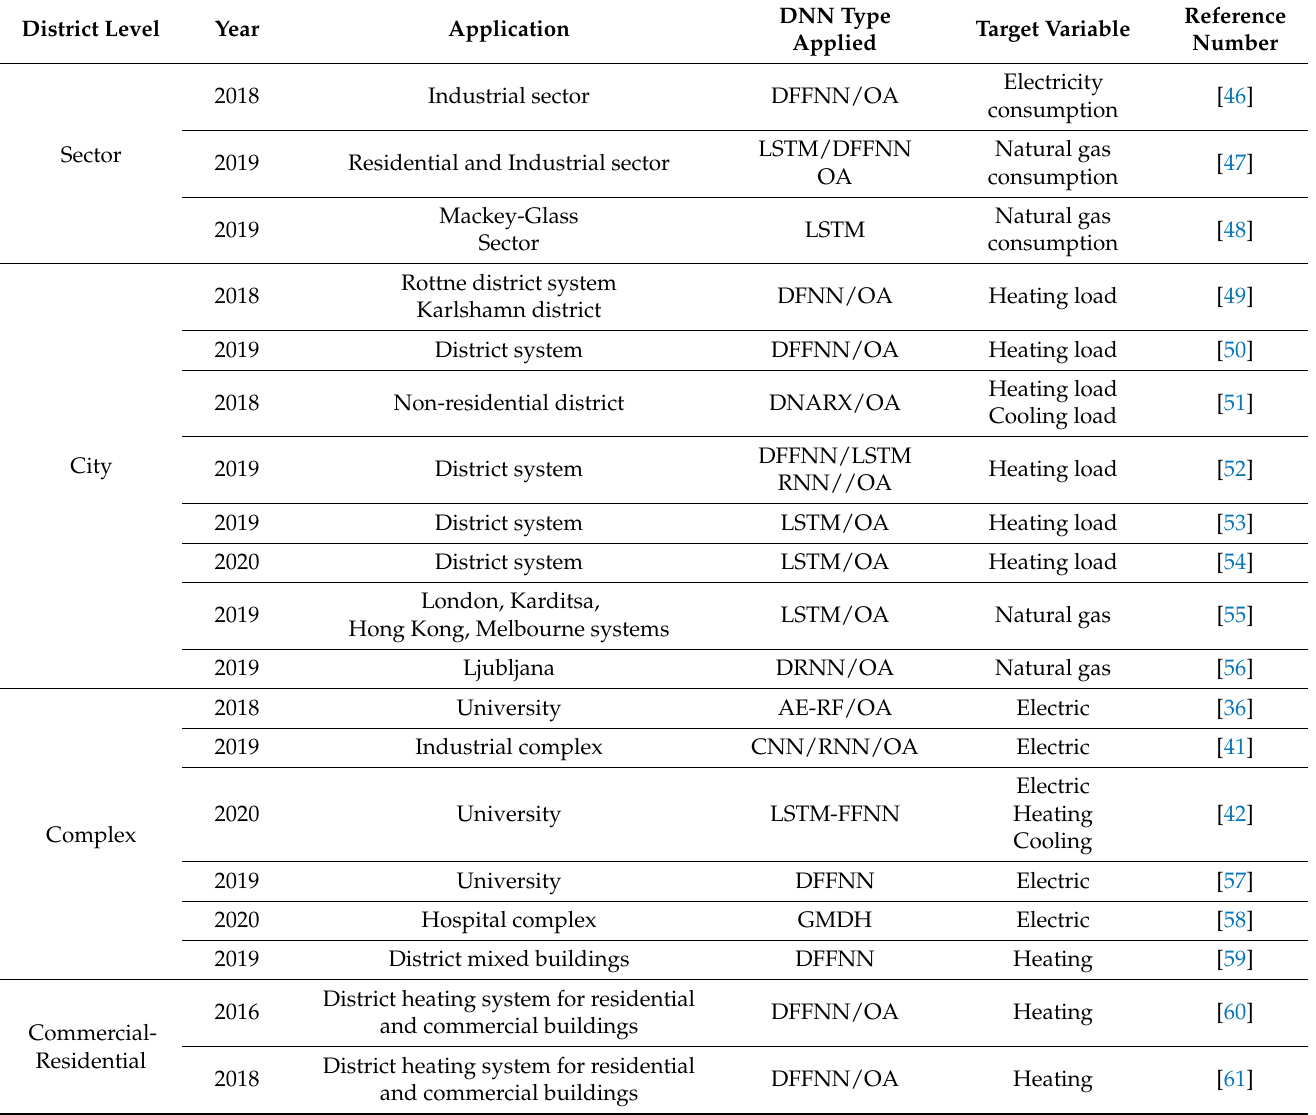
Table A1. District-level DL